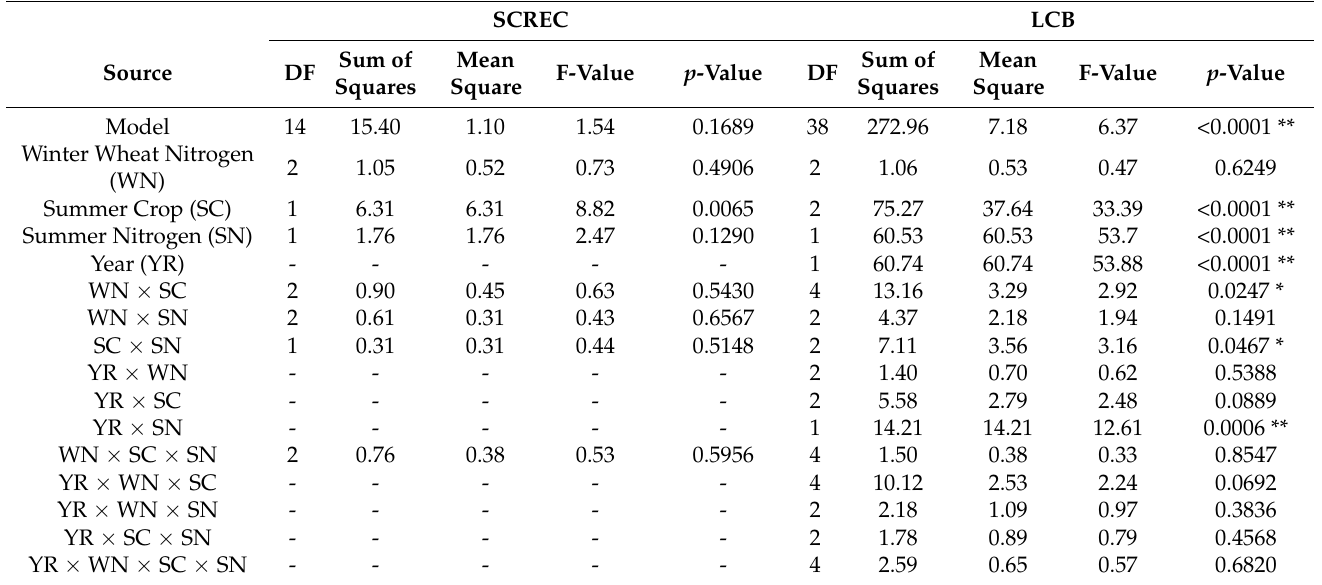
Table 4. ANOVA table with degrees of freedom (DF), sums of squares, mean squares, F -value, and p -value for each of the sources of variances for summer crop dry matter production at two locations in Oklahoma.